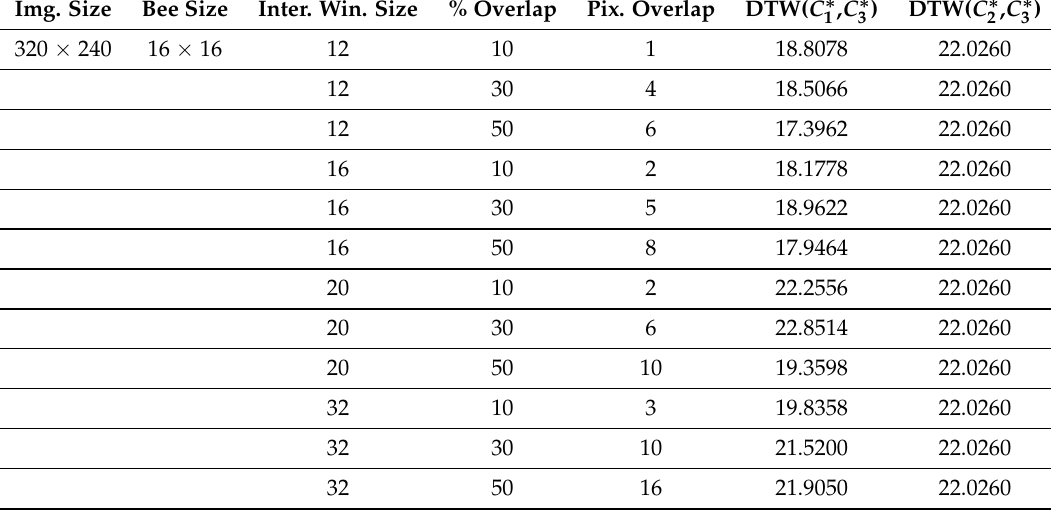
Table A8. DTW values for HT _ Vid . mp 4 with image size of 320 × 240; C ∗ and C ∗ is Human Count (ground 3